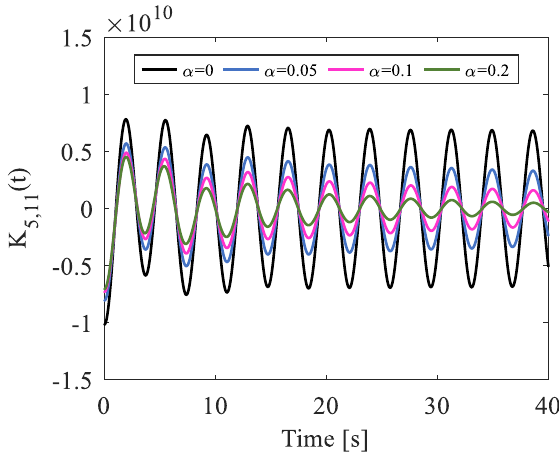
Figure 14. Comparison of the off-diagonal calculated impulse response function K 1,7 , K 3,9 , and K 5,11 between the windward module and middle module of the 3-module model.